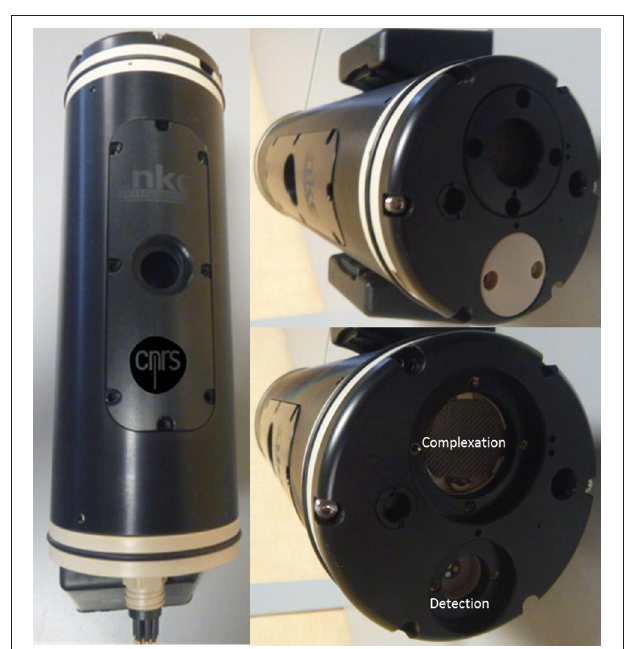
FIGURE 2 | Silicate electrochemical in situ